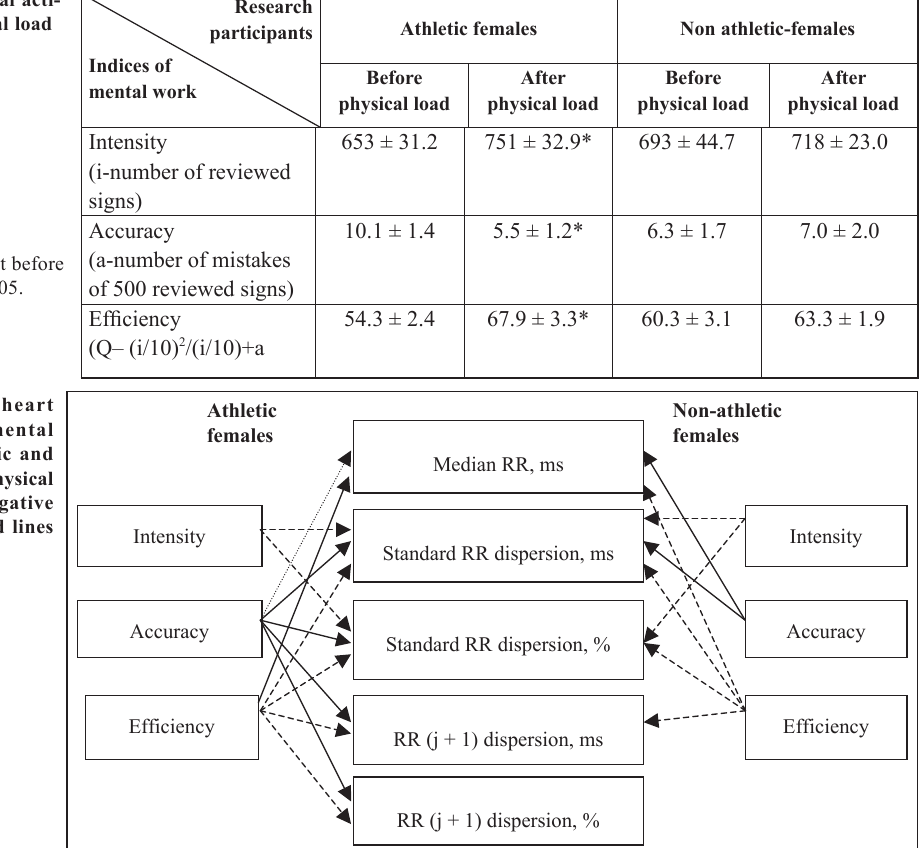
Table 2. Parameters of mental acti- vity before and after physical load